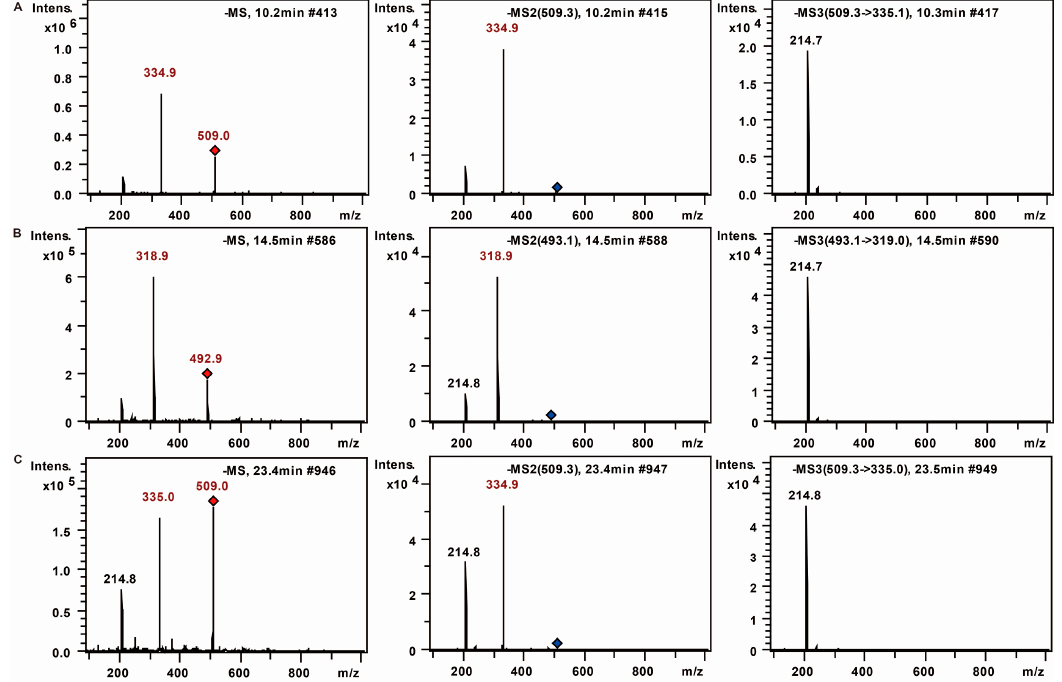
Figure 3. MS ( left ); MS 2 ( middle ); and MS 3 ( right ) spectra of PMP-labeled: mannose ( A ); rhamnose ( B ); and Glucose ( C ).